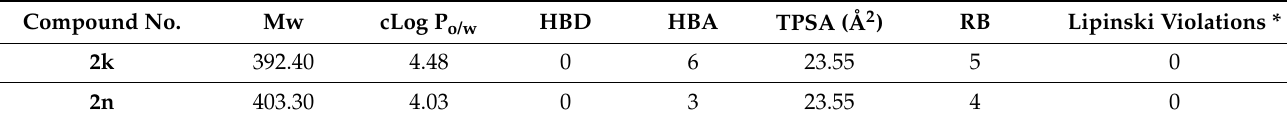
Table 5. Physicochemical properties of 2k and 2n